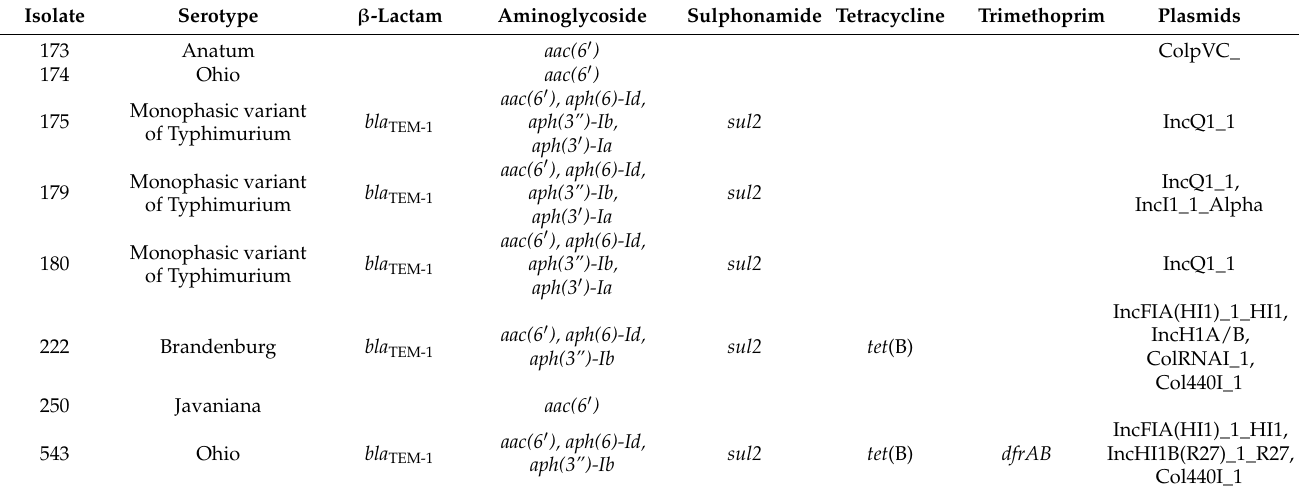
Table 2. T Antimicrobial resistance and plasmids associated with the different